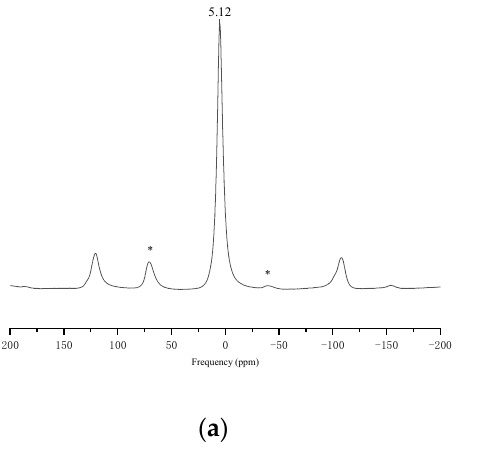
( b ) Figure 9. SEM of ordinary kaolin ( a ) and metakaolin ( b ). The main reaction process of calcining ordinary kaolin to metakaolin in this experi ‐ ment was inferred as “ordinary kaolin reaction (OKR) (4), (5), (6), (7), and (8)” (the form of aluminum was indicated in parentheses after the substance (if aluminum was in ‐ cluded)). The pyrophyllite was the most abundant in ordinary kaolin, which was decom ‐ posed into sillimanite and quartz at 650–850 °C (OKR 4). In the initial stage of calcination, illite and kaolinite were also decomposed, and the former mainly formed sillimanite (OKR 5) and the latter formed amorphous aluminum silicate (AAS) (OKR 6). With the extension of heating time, ordinary kaolin might also have similar consequences produced by over calcination, such as coal ‐ based kaolin, because although the kaolinite content (17.3%) was relatively low, if no over calcination existed, Al (V) might be detected on the NMR spec ‐ trum and the content of amorphous materials might increase obviously rather than the small change from 6.2% (Figure 7a) to 8.9% (Figure 7b), and in addition, the appearance of cristobalite from the conversion of quartz at 650–850 °C proved the existence of over calcination. In OKR 7, Al (IV) and Al (V) in AAS converted to Al (VI), accompanied by the formation of quartz. In the process of over calcination, a part of the quartz (mainly from raw materials before calcination, calcined pyrophyllite and kaolinite) transformed to cris ‐ tobalite (OKR 8).